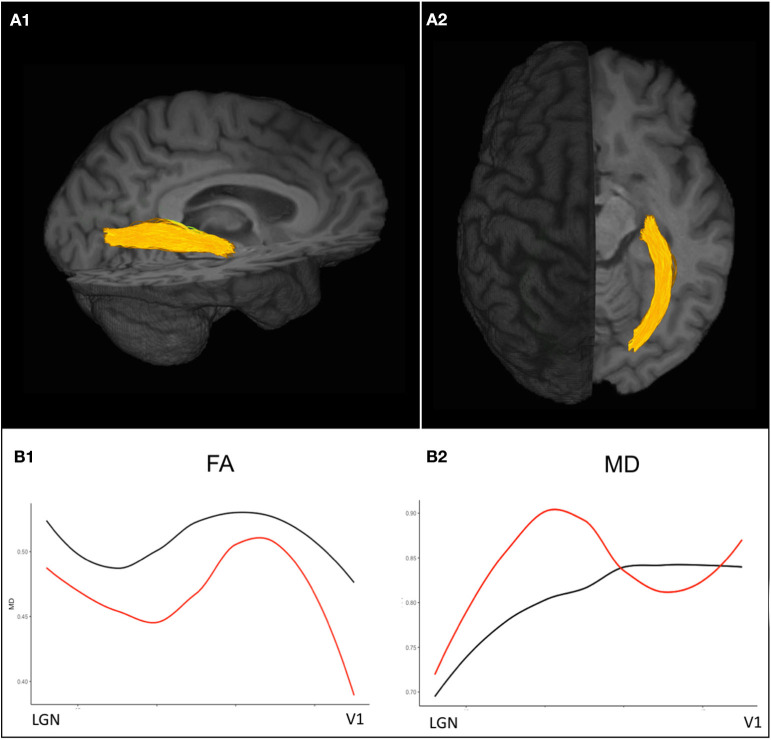
Diffusion-weighted imaging based probabilistic tractography allows for the delineation of the optic radiations displayed in (A1) sagittal and (A2) axial view. (B1) Diffusion tensor imaging (DTI) values along the optic radiation of an exemplary ON patient 3 years after attack (red) show decreased FA values compared to a healthy control (black) indicating trans-synaptic neurodegeneration after ON. (B2) MD values are pathologically increased in an exemplary ON patient almost throughout the entire course of the optic radiations compared to the exemplary healthy control. ON, optic neuritis; FA, fractional anisotropy; MD, mean diffusivity.